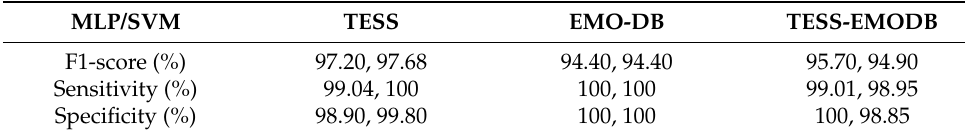
Figure 5. Confusion matrix of emotion classification on the EMO-DB dataset. ( a ) DCNN-NCA-MLP. ( b ) CNN-NCA-SVM. Table 4. Performance Evaluation.